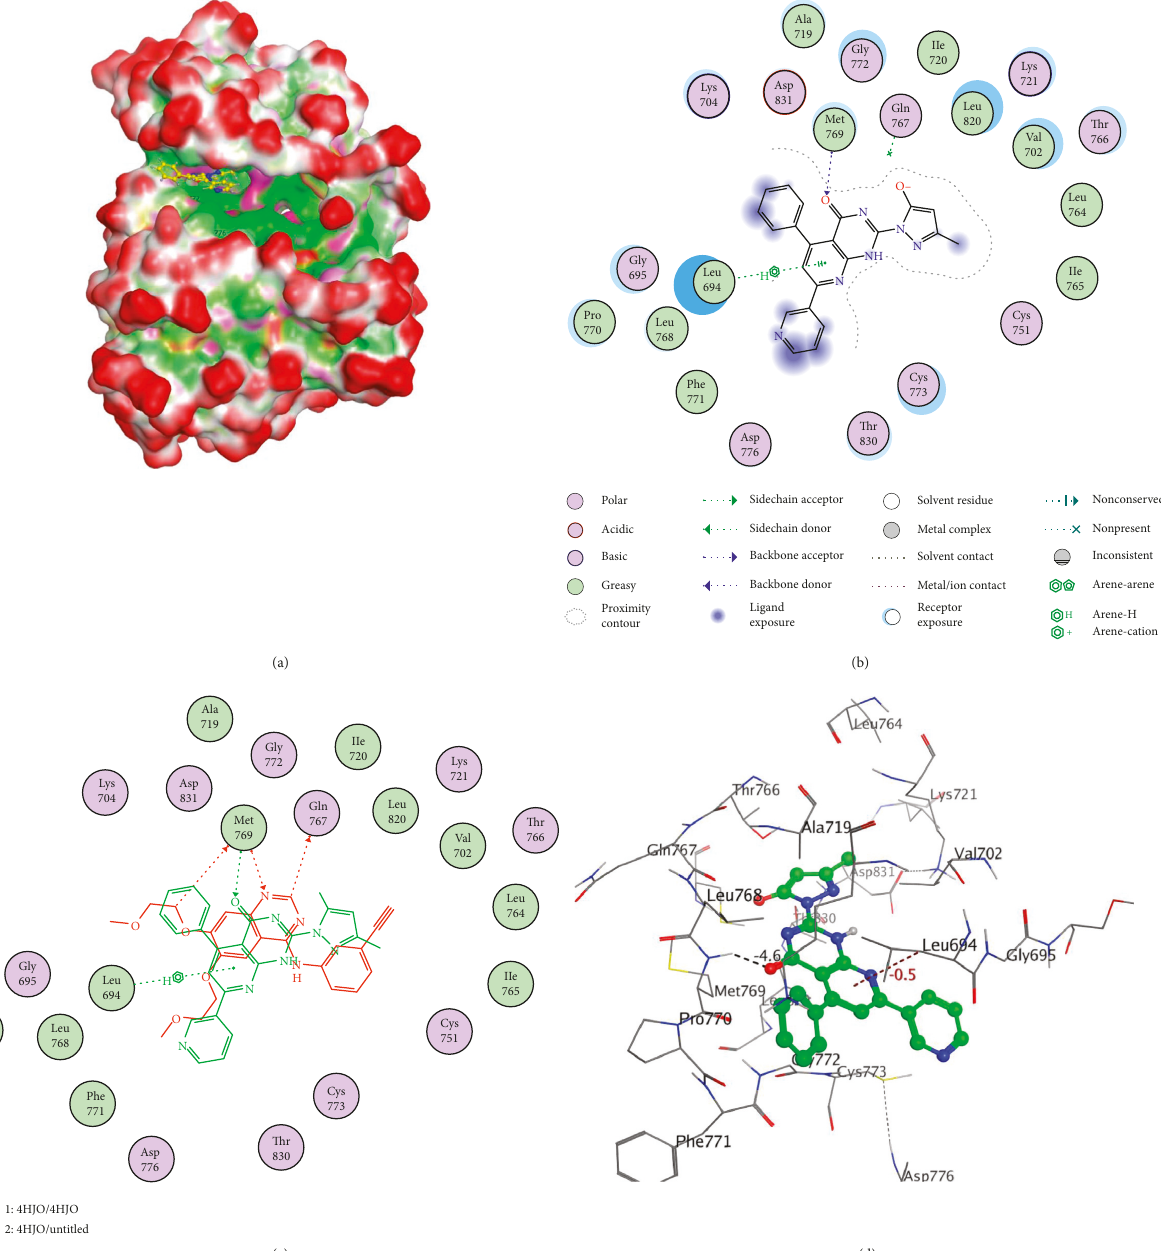
Figure 6: The interaction between compound 6 and EGFR kinase protein (PDB code: 4HJO), presented by MOE 2015: (a, d) 3D compound 6 binding geometry (yellow sticks) in the CDK6 binding site cavity. (b) 2D interaction diagram of compound 6 with the CDK6 binding site cavity. (c) 2D diagrams of compound 6 (green) and erlotinib (red) were